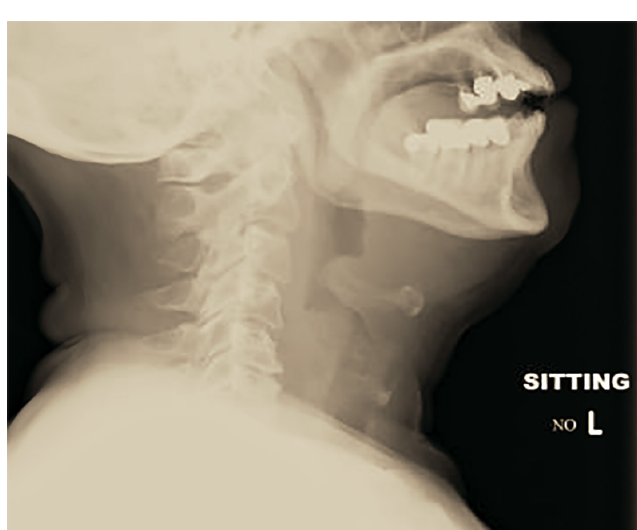
Figure 1. Note the pronounced swelling of the epiglottis, often referred to as